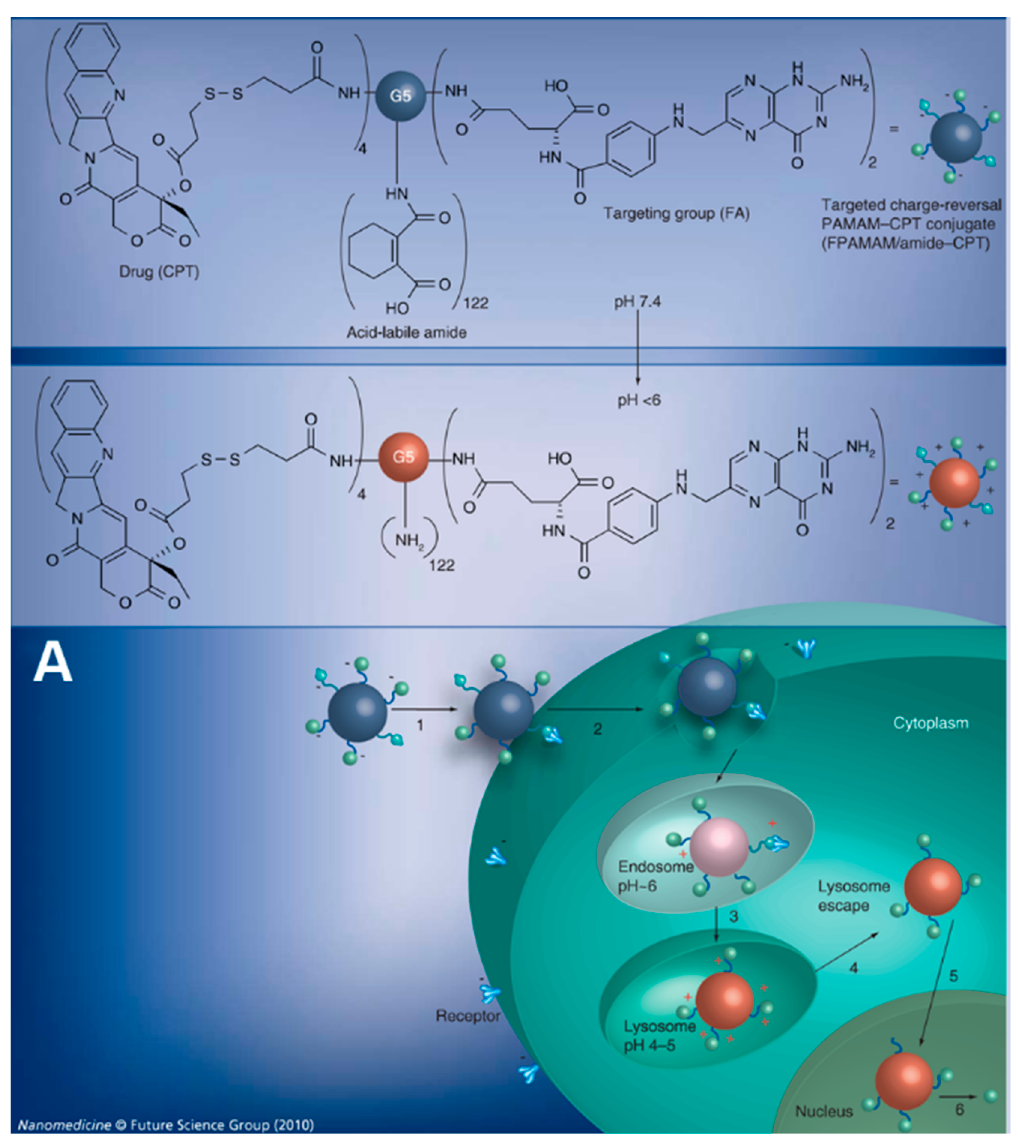
Figure 2. Cont. Figure 2.